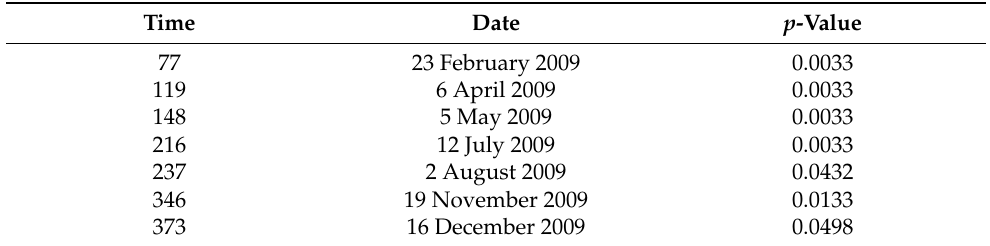
Table 5. Estimated change points for the two-dimensional time series along with the corresponding significance values.